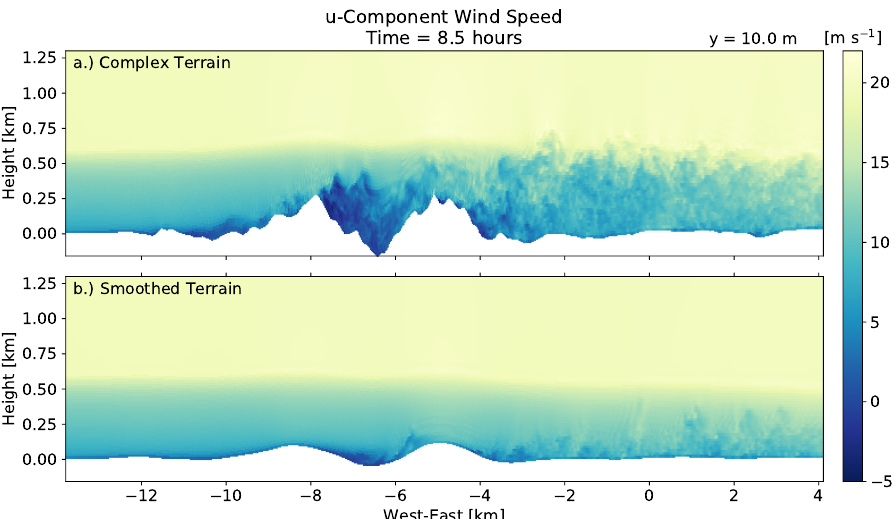
Figure 16. Vertical cross sections of u-component wind speed along the slice, y = 10.0 m for the non-turbulent ( a ) complex terrain and ( b ) smoothed terrain cases in the Fast suite of